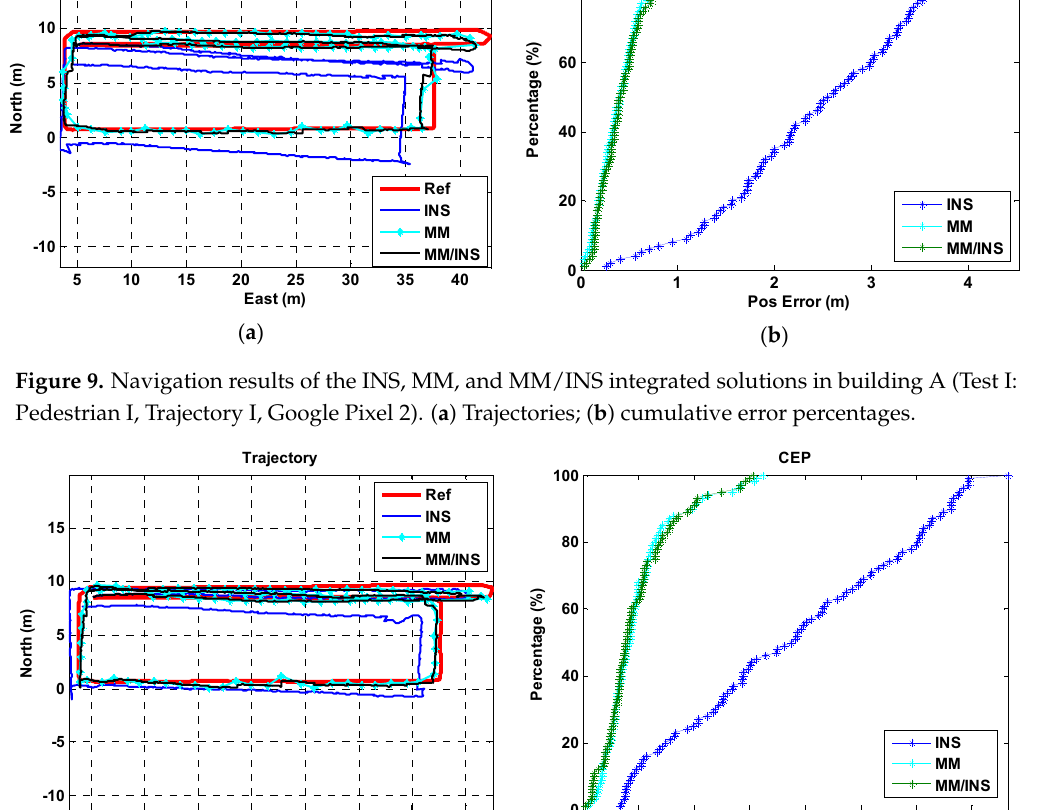
( b ) Figure 12. Navigation results of the INS, MM, and MM/INS solutions in building C (Test IV: Pedestrian III, Trajectory III, Google Pixel 2). ( a ) Trajectories; ( b ) cumulative error percentages. Table 1. Position errors of the INS, MM, MM/INS integrated methods for the four tests (units of m). Test I